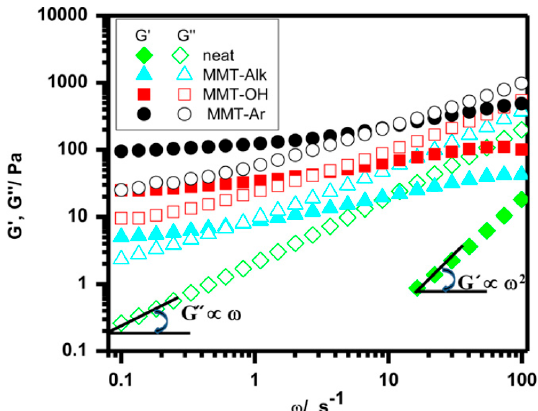
Figure 18. Frequency dependence of the storage ( filled symbols ) and loss ( open symbols ) modulus of PEO (8000 g/mol)–MMT nanocomposites at 75 °C. Reproduced with permission from Kelarakis